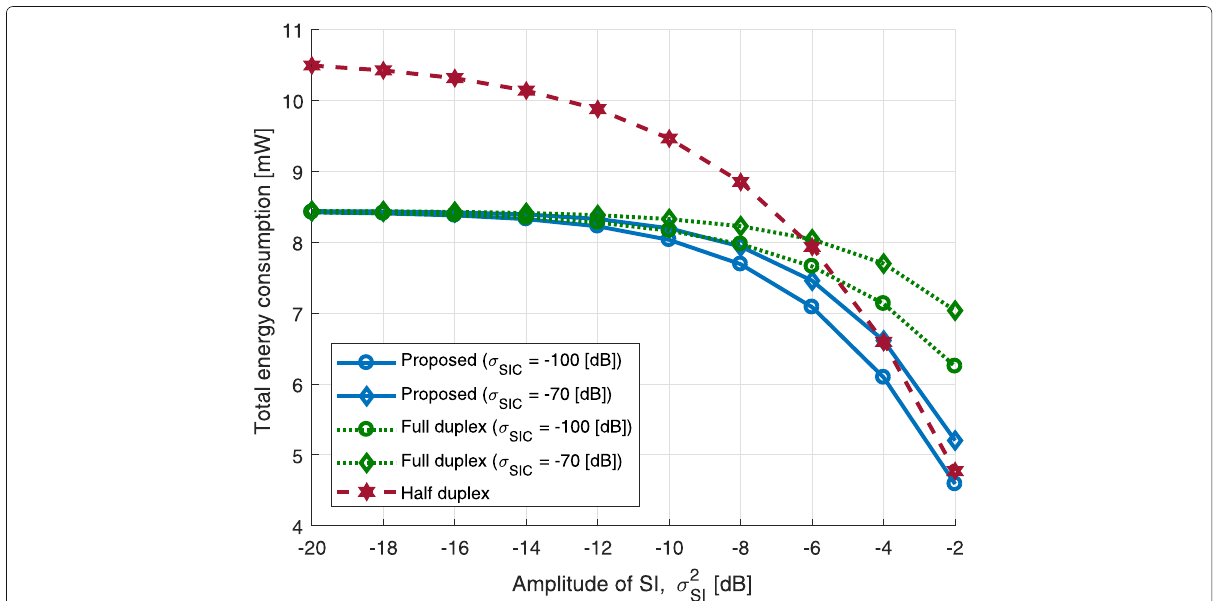
Fig. 3 Total energy consumptions of various systems according to σ 2